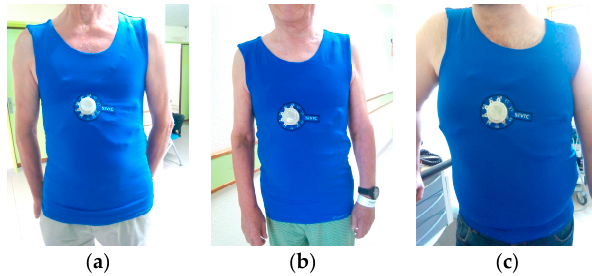
Figure 8. Photos of subjects ( a – c ), wearing the cardiac surveillance T-shirt prototype.